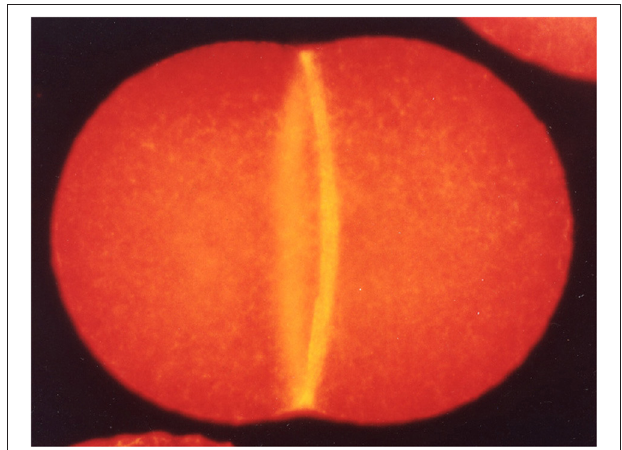
FIGURE 1 | A dividing sea urchin ( Hemicentrotus pulcherrimus ) egg fluorescently stained for F-actin to visualize the CR (Mabuchi, 2008).